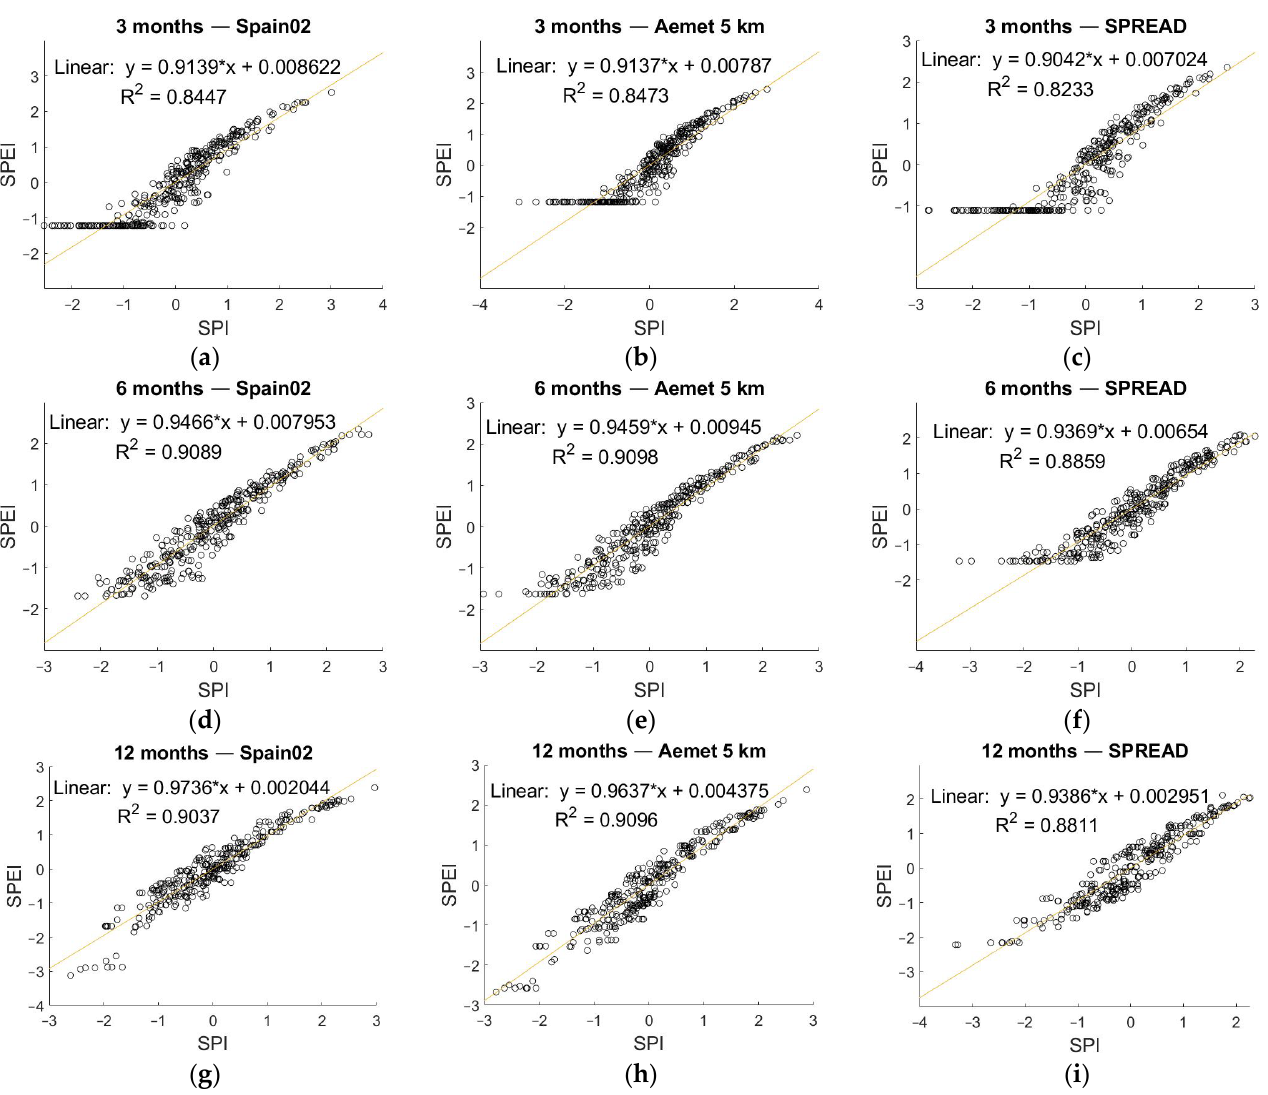
Figure 6. ( a ) Correlation coefficient between SPI and SPEI for the 3 months temporal-aggregation scale for the ( a ) Spain02 database; ( b ) Aemet 5 km database; ( c ) SPREAD and STEAD database. Correlation coefficient between SPI and SPEI for the 6 months temporal-aggregation scale for the ( d ) Spain02 database; ( e ) Aemet 5 km database; ( f ) SPREAD and STEAD database. Correlation coefficient between SPI and SPEI for the 12 months temporal-aggregation scale for the ( g ) Spain02 database; ( h ) Aemet 5 km database; ( i ) SPREAD and STEAD